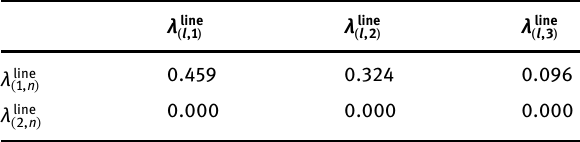
Table 3: The orders of singularities along the singular line, ( ) λ l n line ,